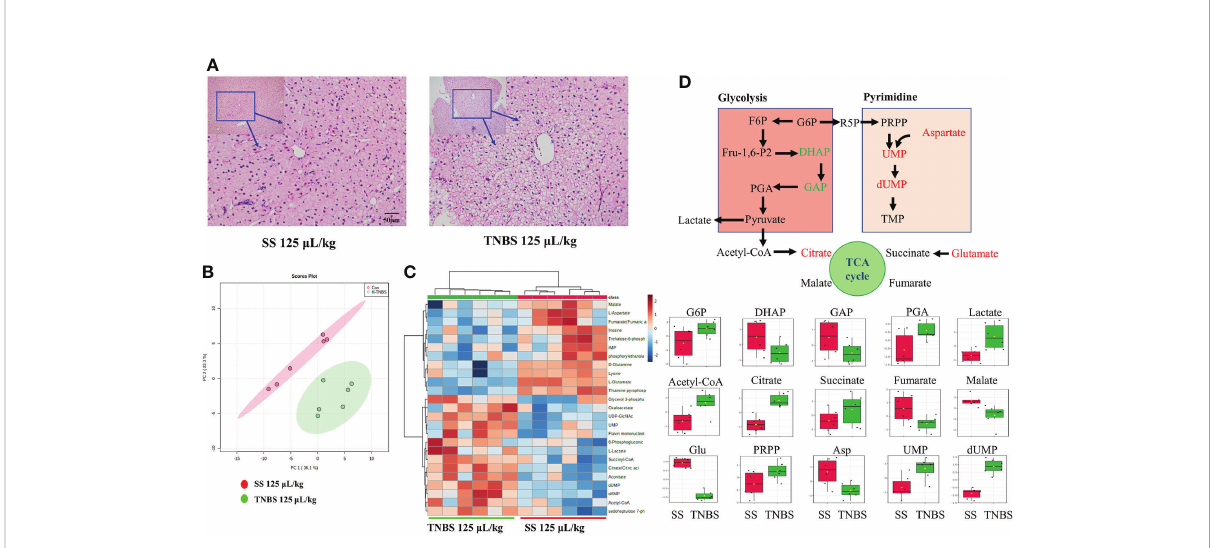
FIGURE 5 The effect of TNBS on the liver in fl ammation and energy metabolism. (A) The 25 m L/kg SS and 125 m L/kg TNBS representative microphotograph of H&E staining paraf fi n-embedded sections of liver was shown (scale bar: 50 m m). (B) The PCA score plots of energy metabolism in two groups. (C) Heatmap of energy-related metabolites of two groups. (D) Schematic fi gure showing the energy metabolism, and box plots of the relative abundance of metabolites, red and green colors indicate signi fi cant up- and downregulation, respectively. N=6.